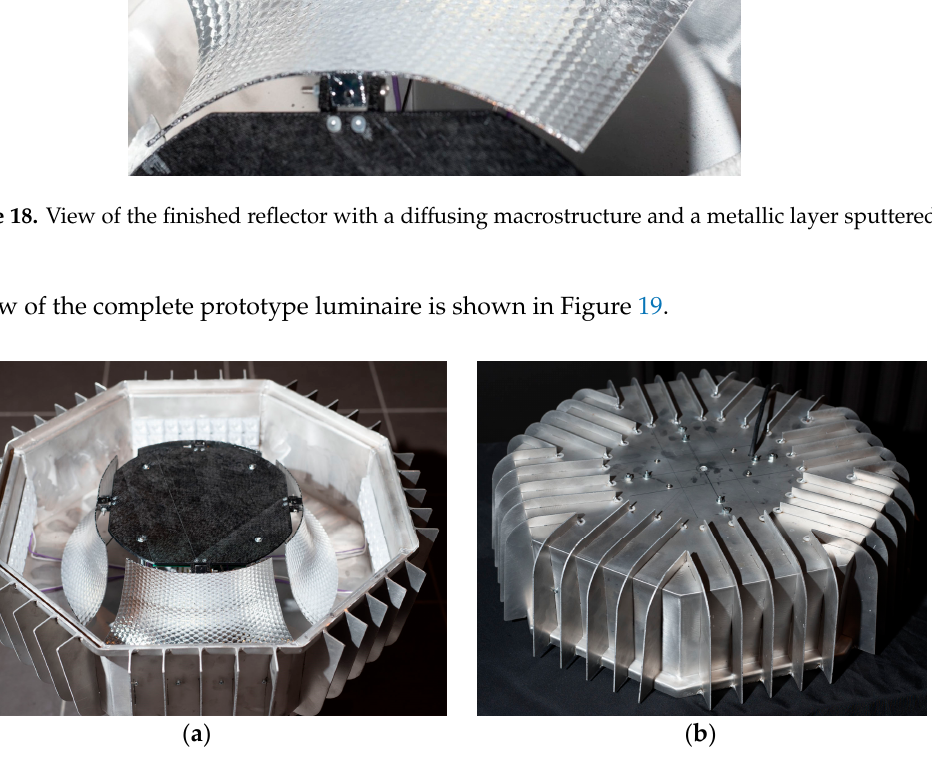
Figure 19. View of a complete prototype luminaire: ( a ) bottom with optical system, ( b ) top with radiator.